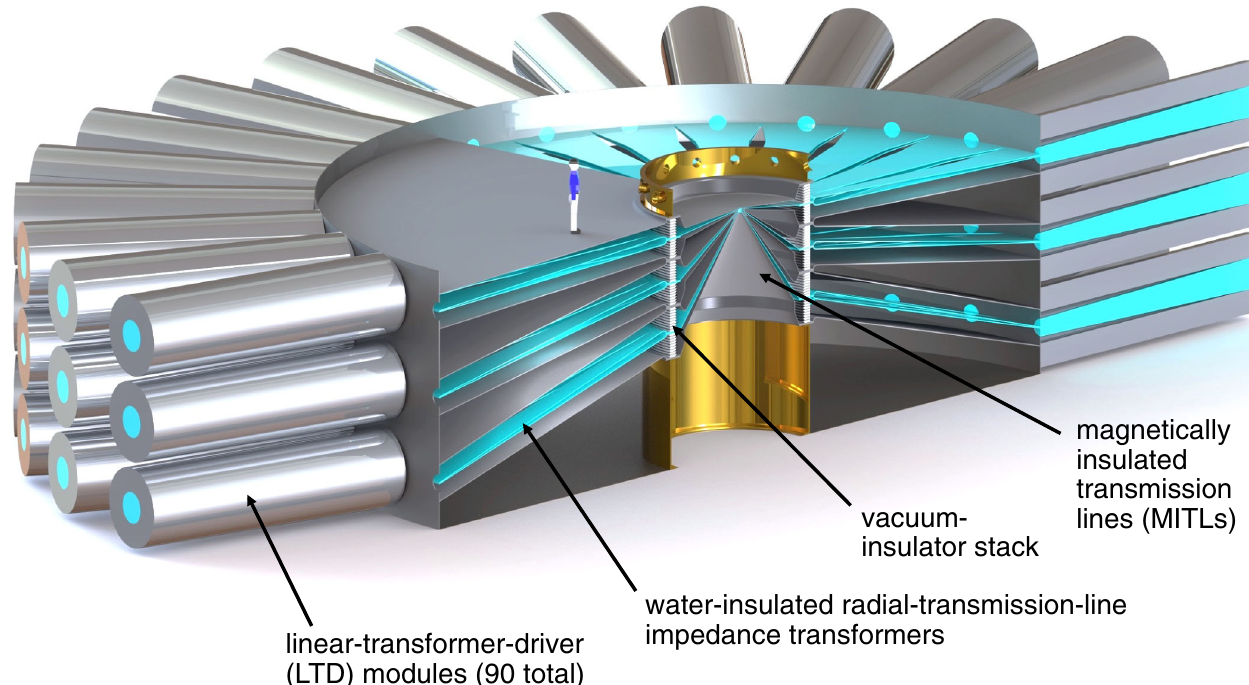
FIG. 1. Cross-sectional view of a three-dimensional model of the Z-300 accelerator. The model includes a person standing on the uppermost water-section electrode, near the centrally located vacuum section. The outer diameter of Z 300 is 35